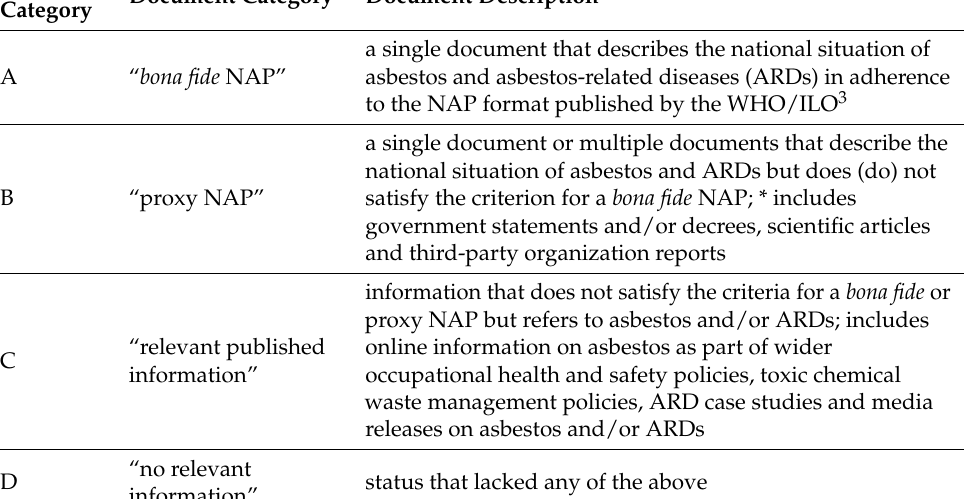
Table 1. Country and Document